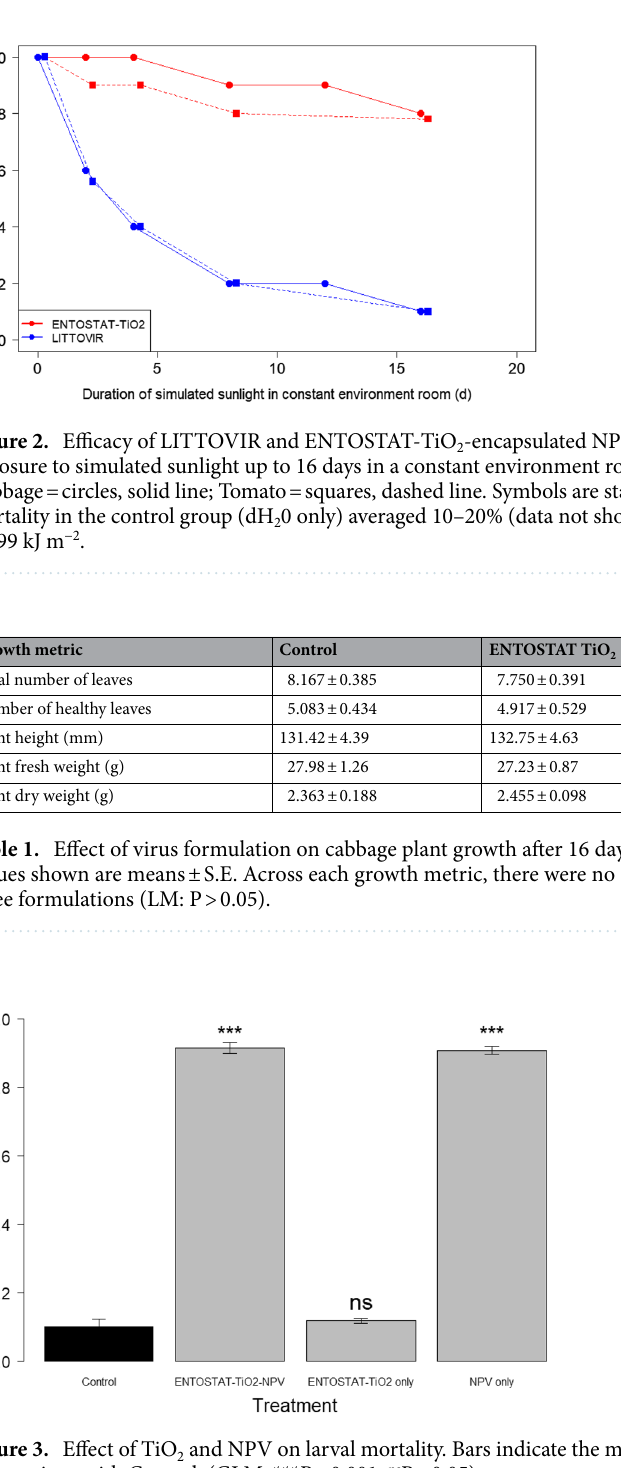
Figure 3. Effect of TiO 2 and NPV on larval mortality. Bars indicate the means and error bars are ± S.E. Comparison with Control: (GLM: ***P < 0.001, ns P >